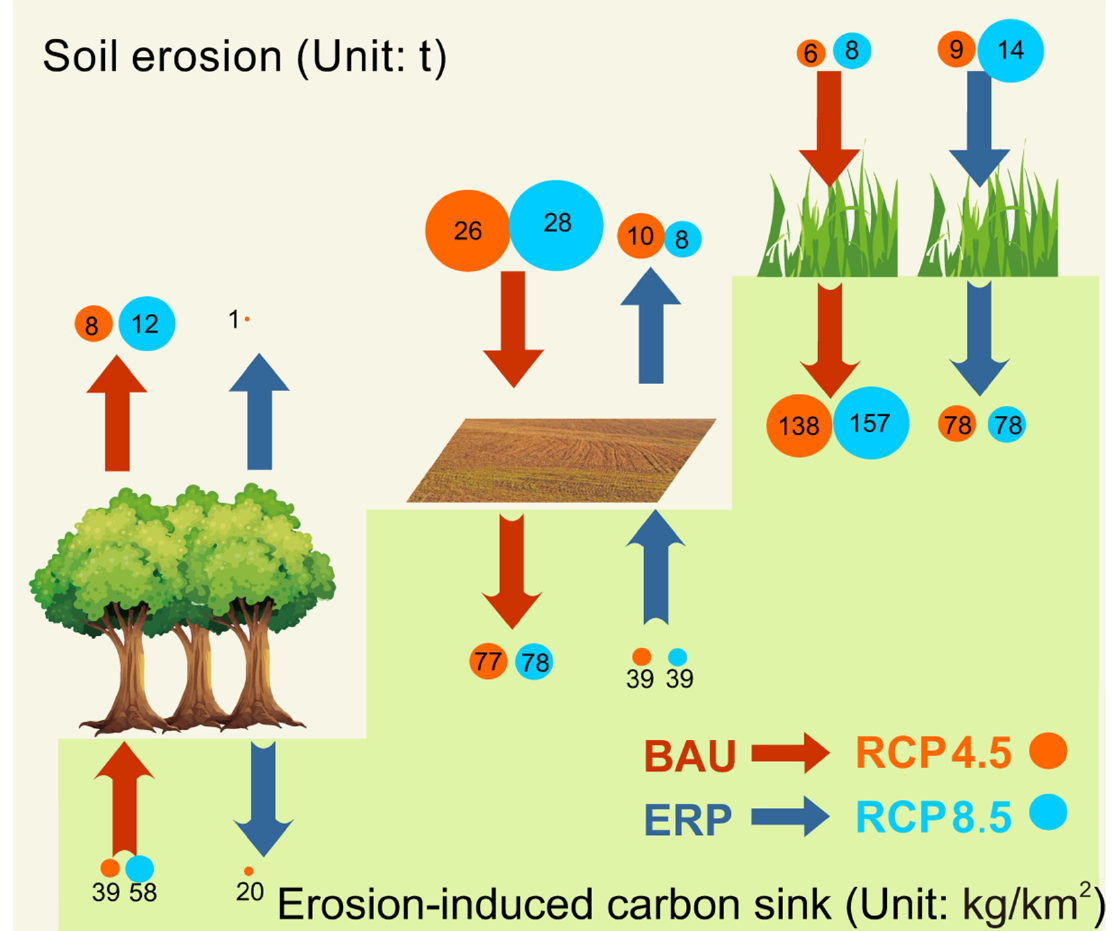
Figure 6. Comparative results of multiple approaches to reducing soil erosion and increasing erosion − induced carbon sinks.